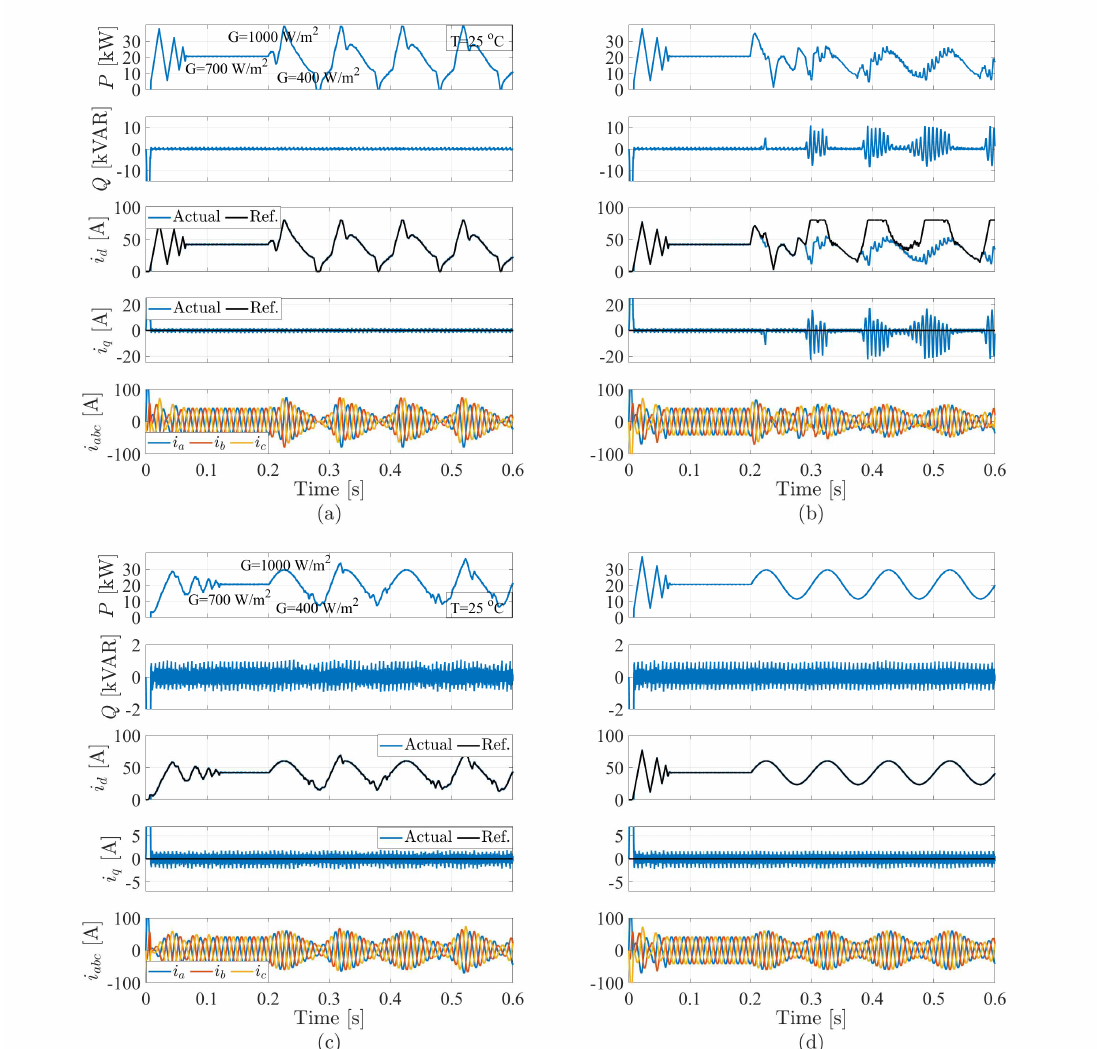
Figure 19. Grid-connected inverter behavior with sinusoidal changes to radiation (from top): Grid-injected active power, reactive power, d -axis current, q -axis current, and the abc currents for: ( a ) P&O method; ( b ) modified P&O; ( c ) multi-power-sample method; ( d ) the proposed model-based